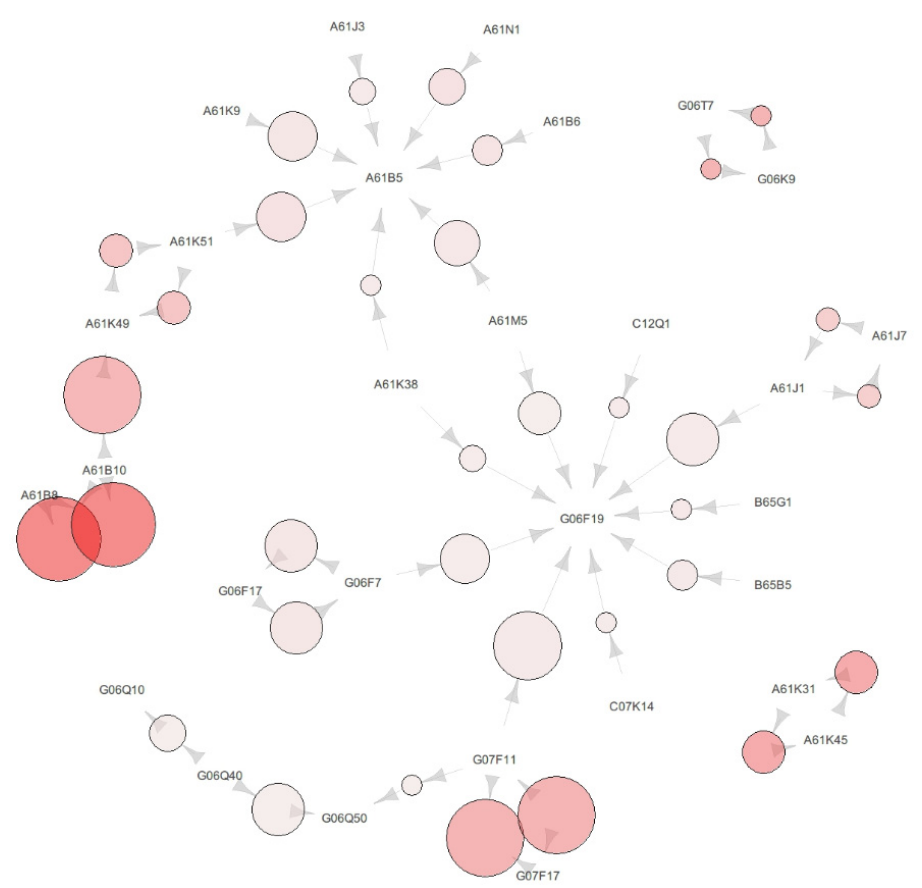
Figure 4. Association map of pharmaceutical technology from 2008 to 2015.